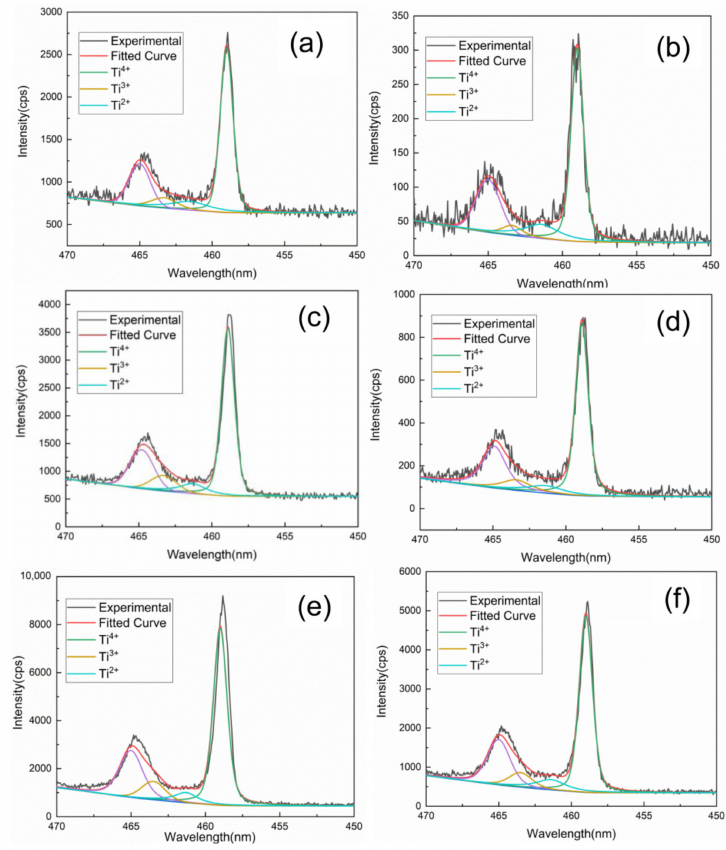
Figure 8. XPS spectrum of Ti 2p at different heating times: ( a ), ( c ) and ( e ) mechanical grinding at 0.5, 2 and 10 h, ( b ), ( d ) and ( f ) laser cleaning at 0.5, 2 and 10